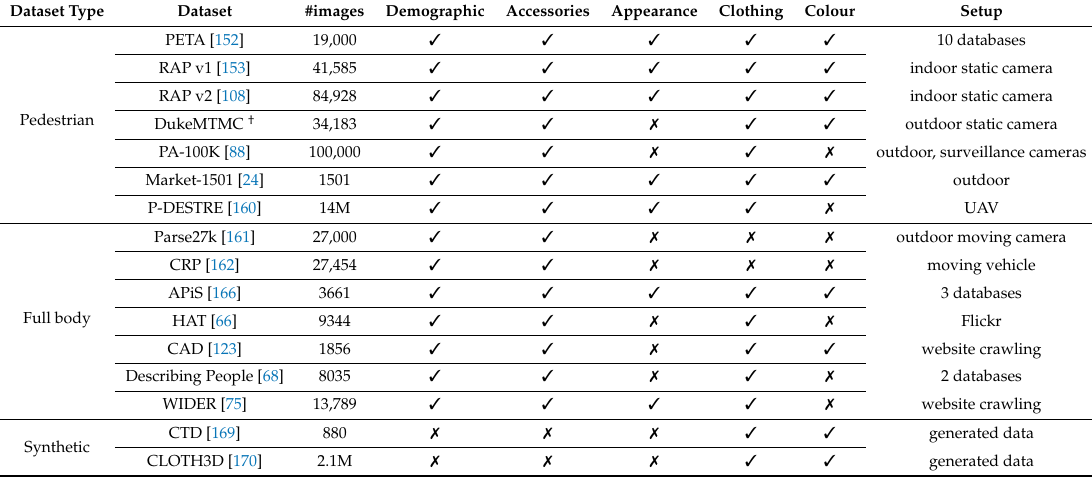
Table 1. Pedestrian attributes